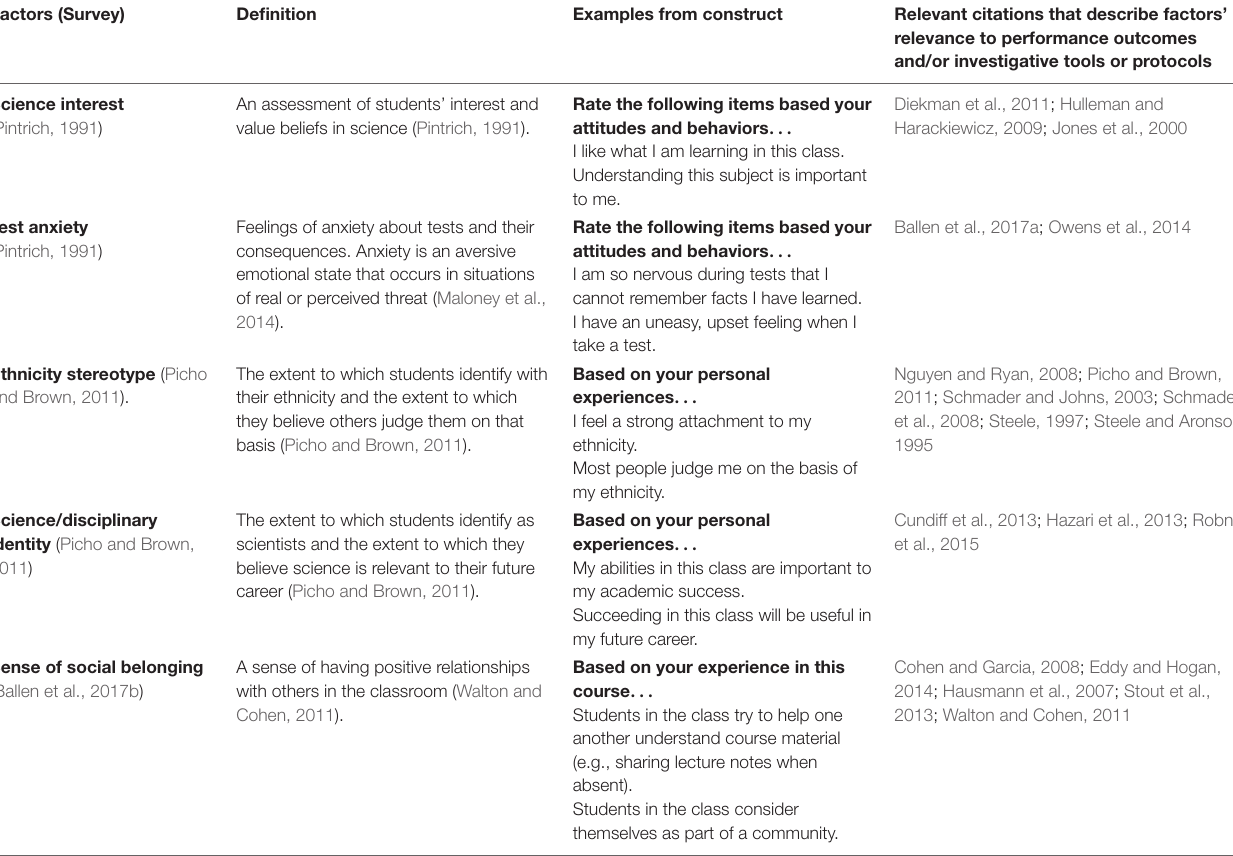
TABLE 1 | Candidate social psychological factors that impact student performance according to previous research.